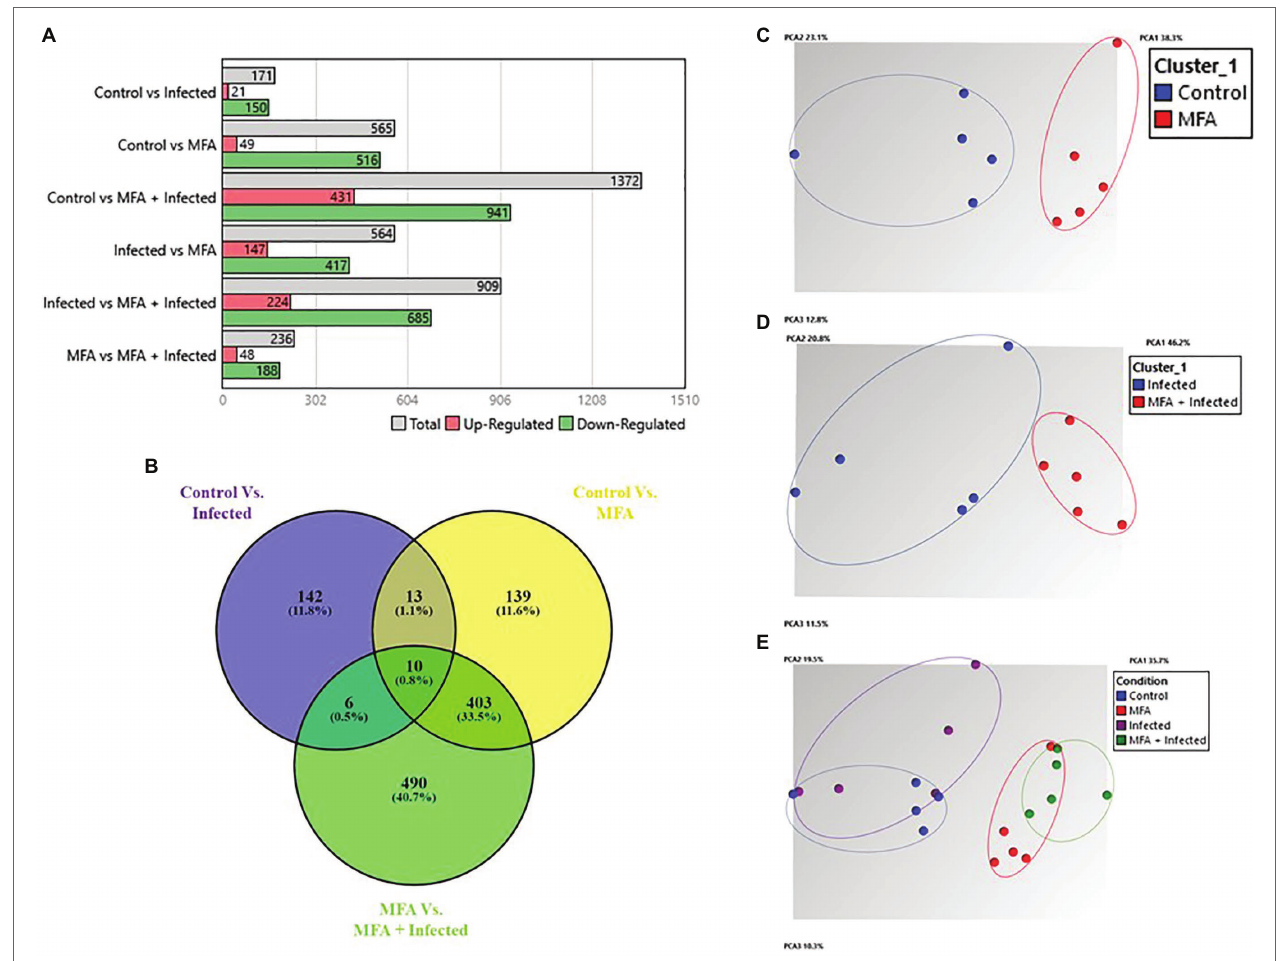
FIGURE 3 | Summary of gene expression data from Citrus sinensis . (A) Number of significantly differentially expressed genes between different combinations of experimental groups. (B) Venn diagram displaying number of intersecting genes between healthy and HLB-infected Citrus sinensis following treatment with MFA. Venn diagram was generated by comparing gene expression sets. Venn diagram displays the common tally of genes that are impacted by the experimental conditions. Numbers represent significantly differentially expressed genes ( p < 0.05), and percentages represent the percentage of the total tally. (Oliveros, 2007– 2015). Venny 2.1.0. https://bioinfogp.cnb.csic.es/tools/venny/. (C–E) Principal component analysis (PCA) plots indicating relationships between differentially expressed genes in MFA-treated samples and control treatments. Oval shapes indicate treatment grouping (control, infected, MFA, MFA + infected). A , C , D , and E graphs were generated by the TAC